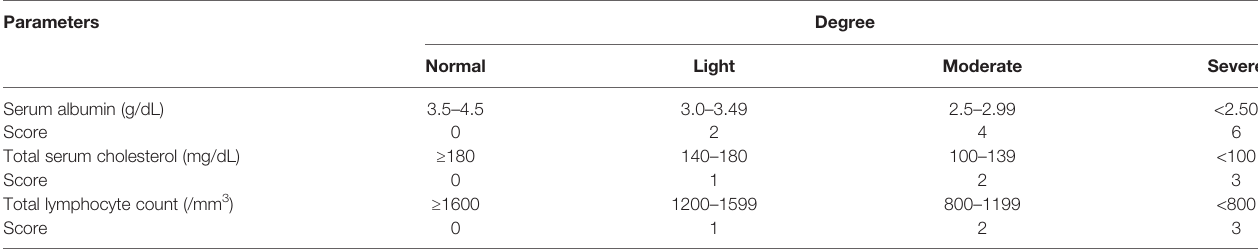
CONUT, controlling nutritional